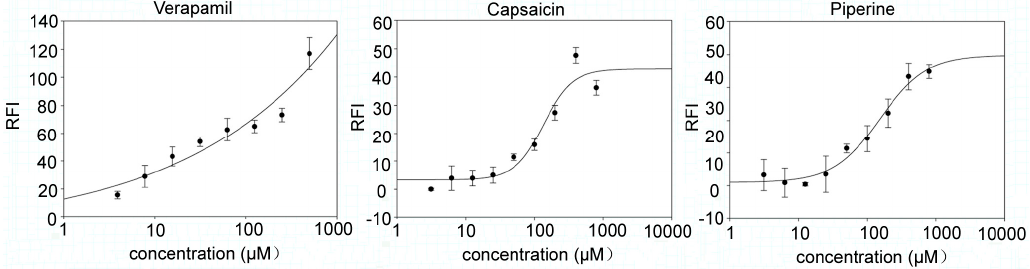
Figure 3. Effects of alkaloids and the positive control with verapamil on rhodamine (Rho) 123 retention in Caco-2 cells. Cells treated with DMSO were used as a solvent control. Data are presented as the mean ± SD.